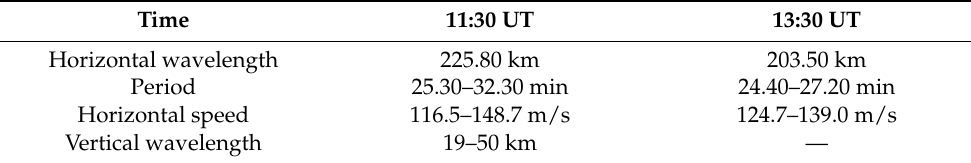
Table 1. Propagation parameters of the recorded